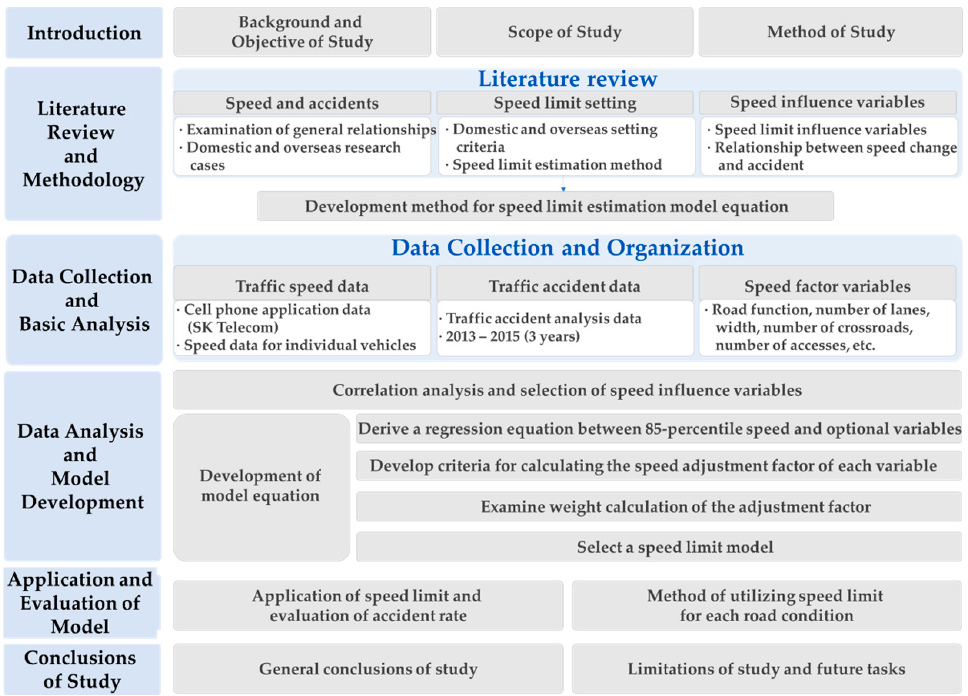
Figure 1. Process of the study.